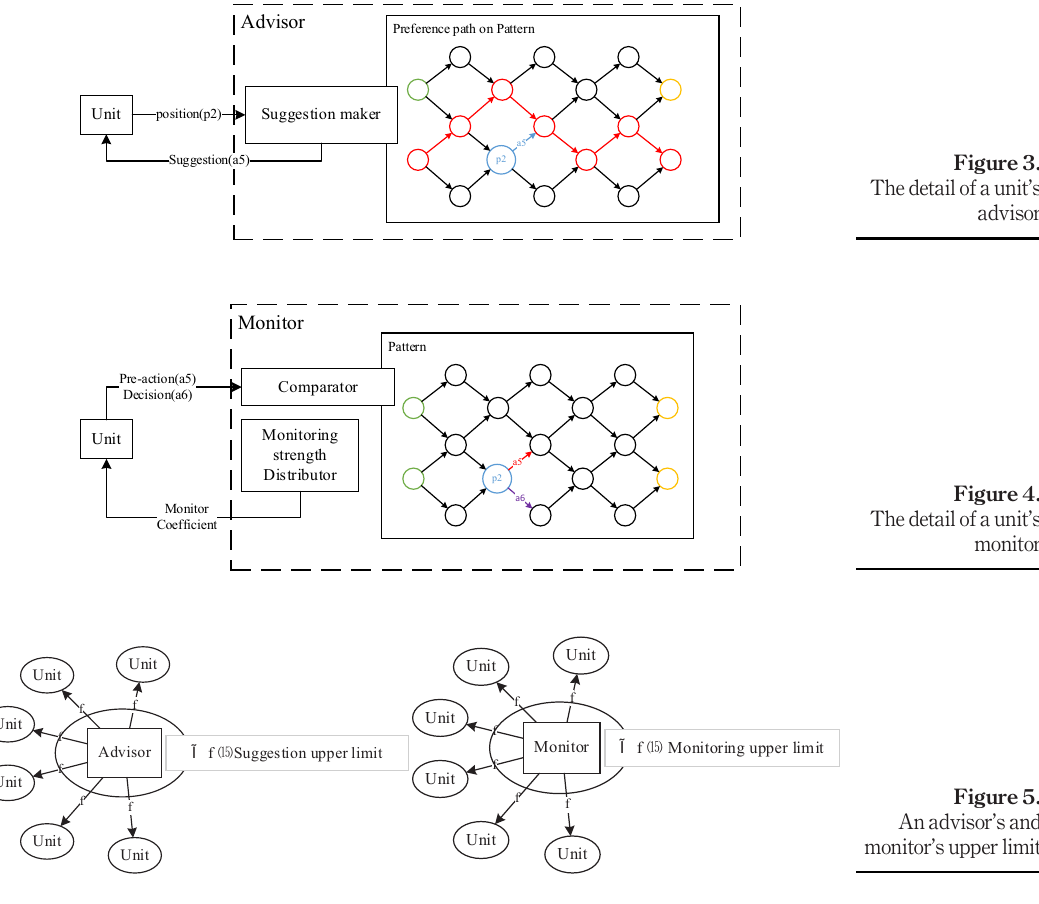
Figure 3. The detail of a unit ’ s